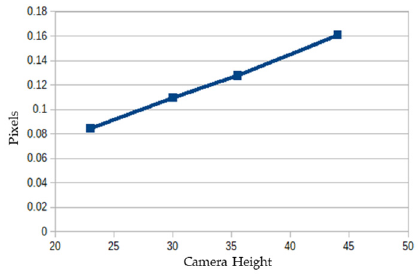
Figure 13. Relationship between centimeters and pixels with the camera height.